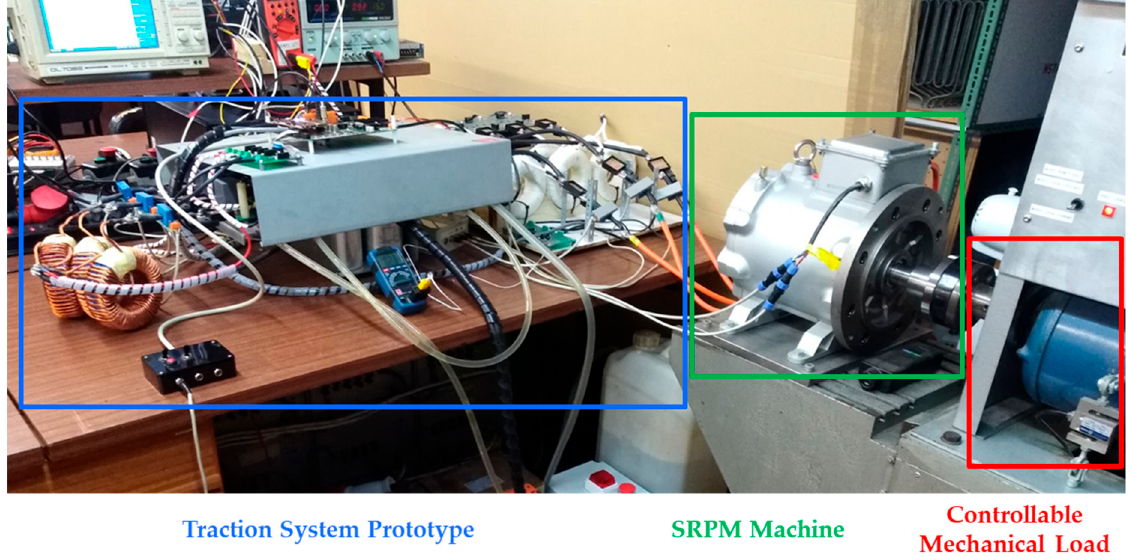
Figure 10. Traction system prototype workbench overview.